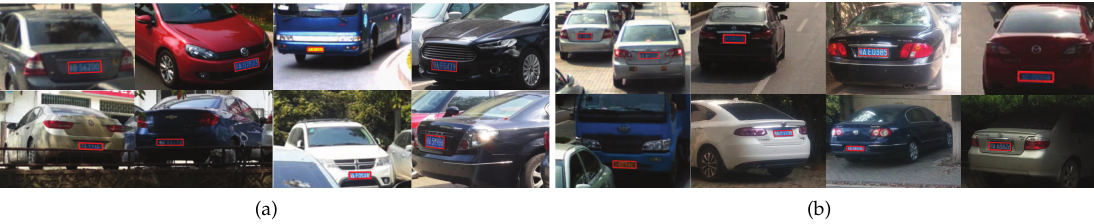
Figure 7. Some representative detection results of our MOSI-LPD on challenging data: ( a ) performance on blurred images; ( b ) performance on images with noise.